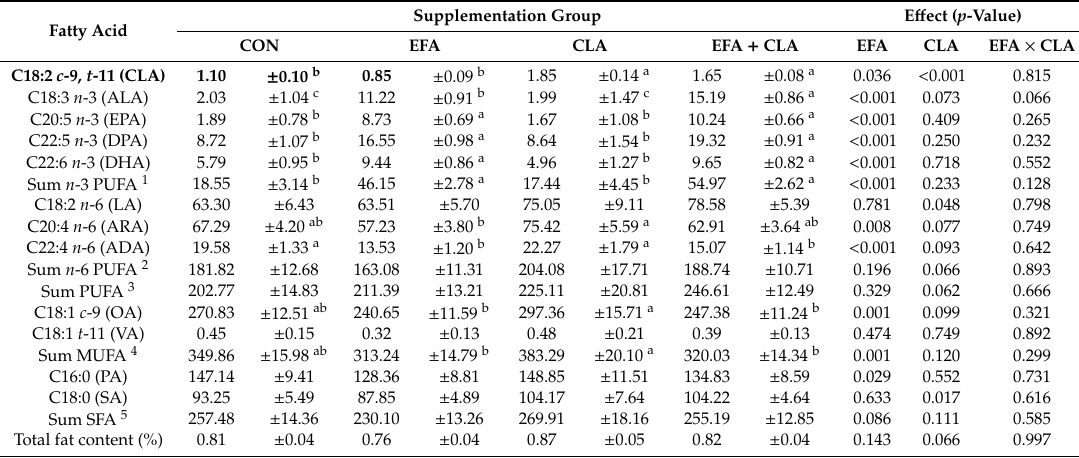
Table 1. Fatty acid concentration (mg / 100 g tissue) in longissimus muscle of calves of four maternal supplementation groups: Control group (CON, n = 8), essential fatty acids (EFA, n = 9), conjugated linoleic acids (CLA, n = 8), EFA + CLA (n = 11). Data are given as LSM ± SE LSM . Results for all measured fatty acids are listed in Supplementary Table